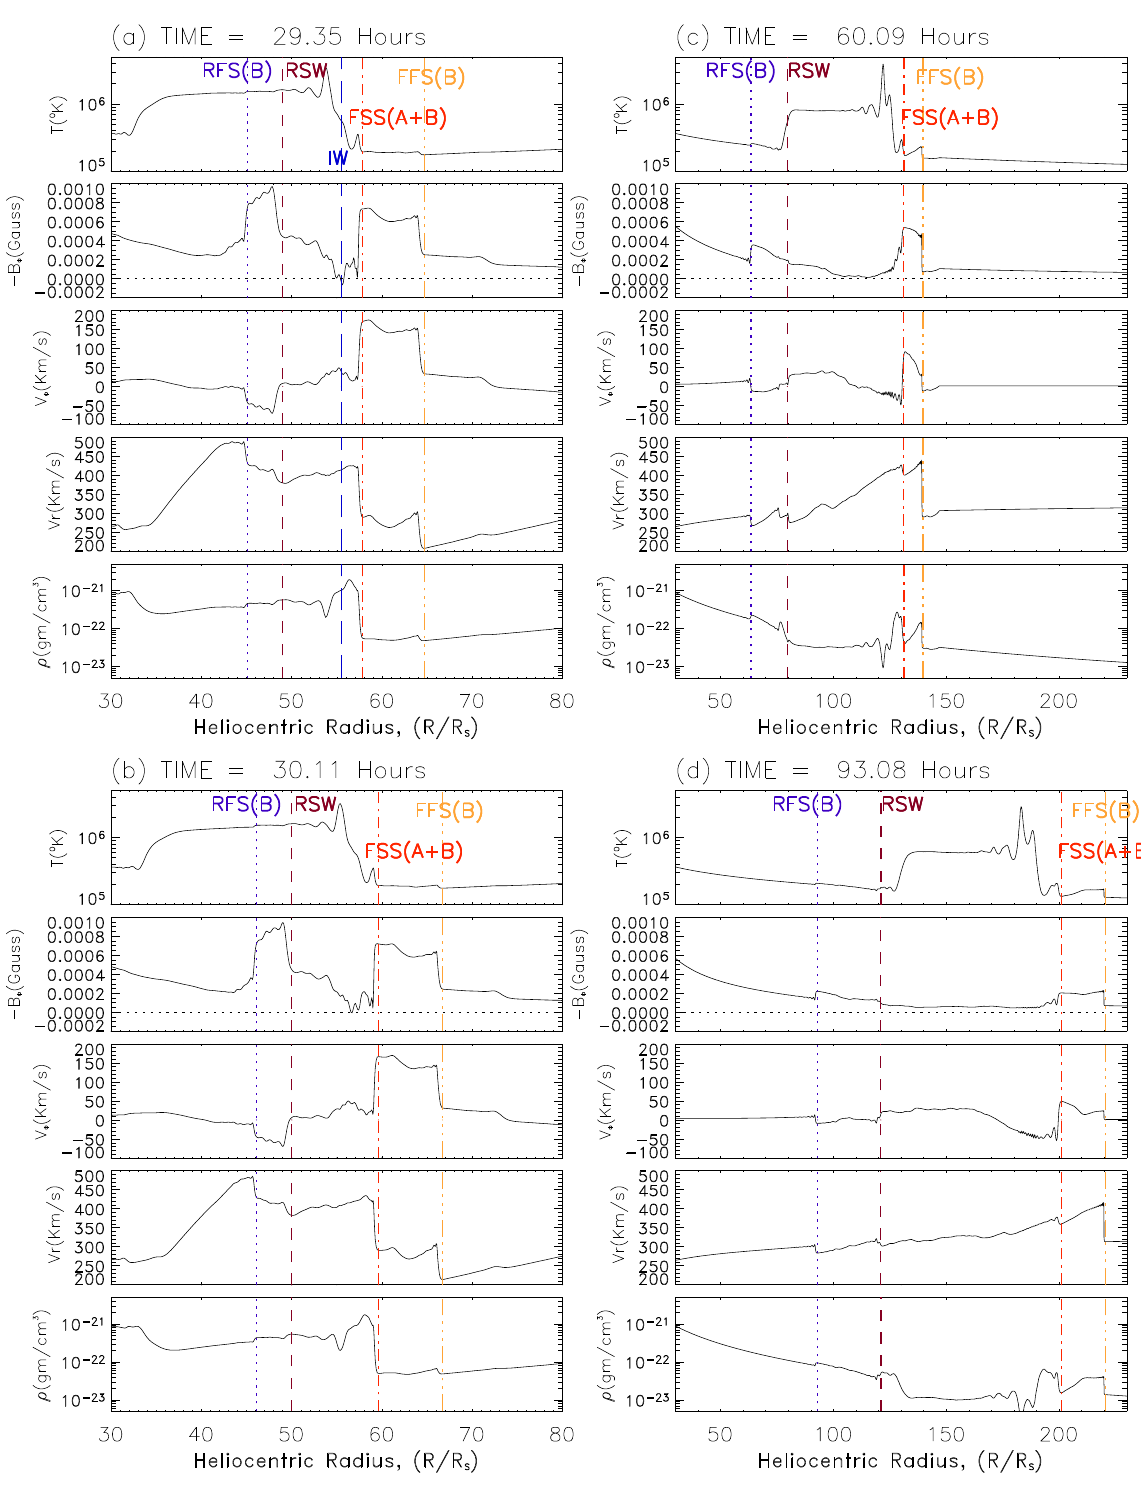
0 00 = 0 . 4 , T 0 = 0 . 4 v = 1 . 6 , T 00 (cid:1)(cid:2) r r =5.0. (a) , (b) , (c) and (d) show the solar v r ◦ v r ◦ T ◦ T ◦ (cid:0)